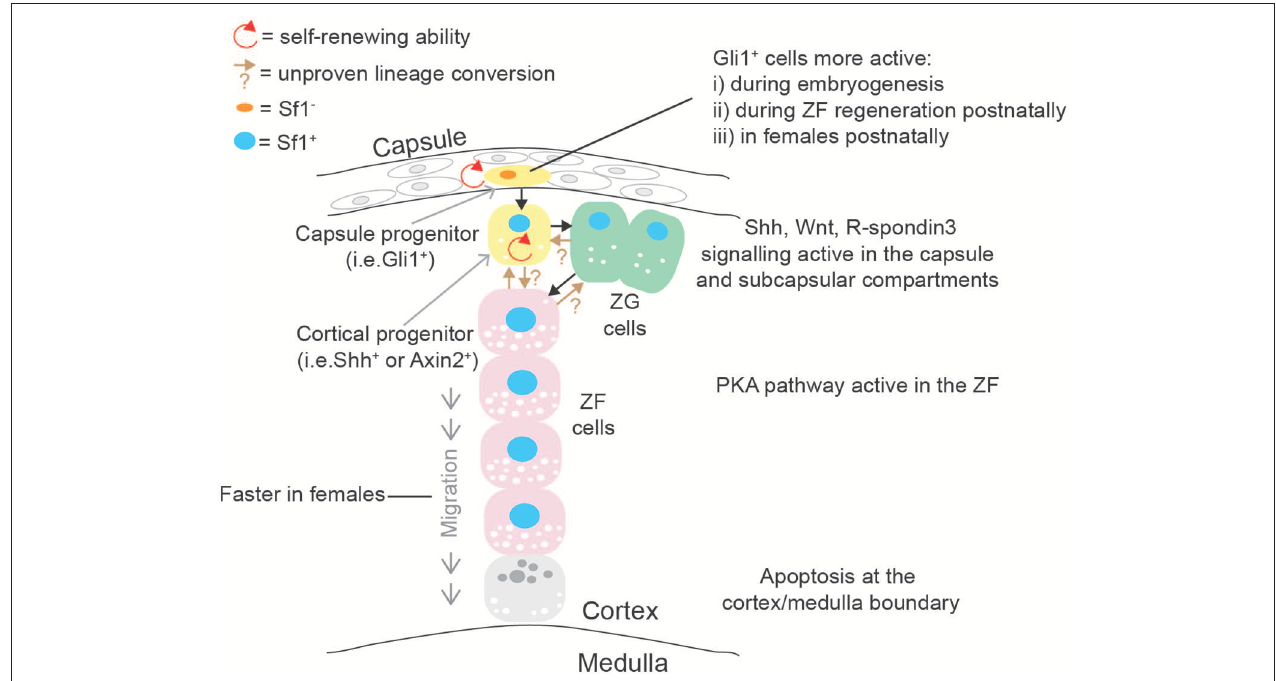
FIGURE 4 | Schematic representation of post-natal adrenal cortex centripetal streaming and self-renewal in mice. Gli1 + cells in the capsule can give rise to Sf1 + /Shh + cortical cells: both are self-renewing adrenocortical progenitor cell populations. Shh + cells can become ZG cells, and ZG cells can lineage convert to ZF cells, which migrate centripetally. Direct differentiation between Shh + cells and ZF is probably occurring in parallel. These differentiation events are governed by pathways mostly active in the capsular/subcapsular region, while apoptotic figures are observed at the cortex/medulla boundary in senescence